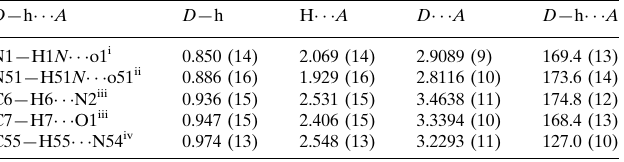
Hydrogen-bond geometry (A˚ , (cid:3)